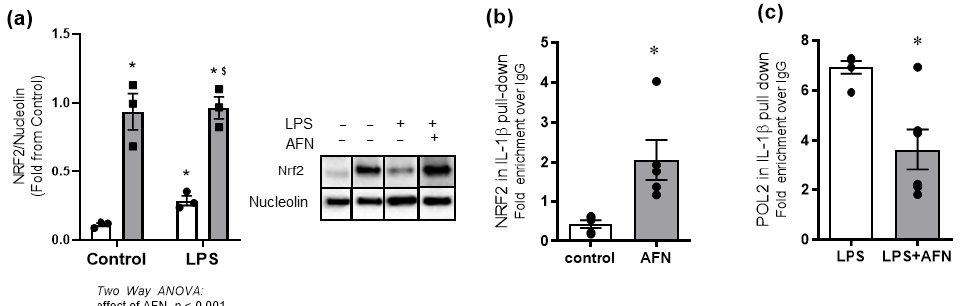
Figure 6. NRF2 nuclear localization and binding to IL1- β promoter. ( a ) Nuclear localization of NRF2 protein was identified at 1 h post AFN treatment. ( b ) Chromatin immunoprecipitation (ChIP) assay using IL-1 β antibody revealed NRF2 protein directly binds to the Il1b promoter and ( c )